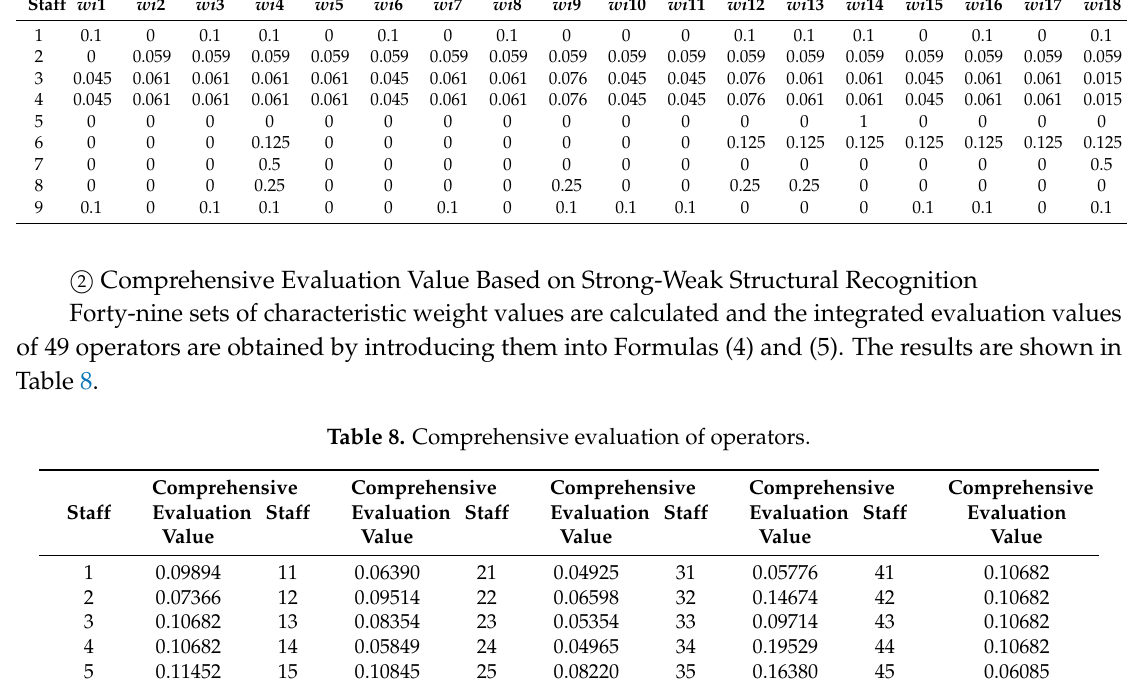
Table 8. Comprehensive evaluation of operators.